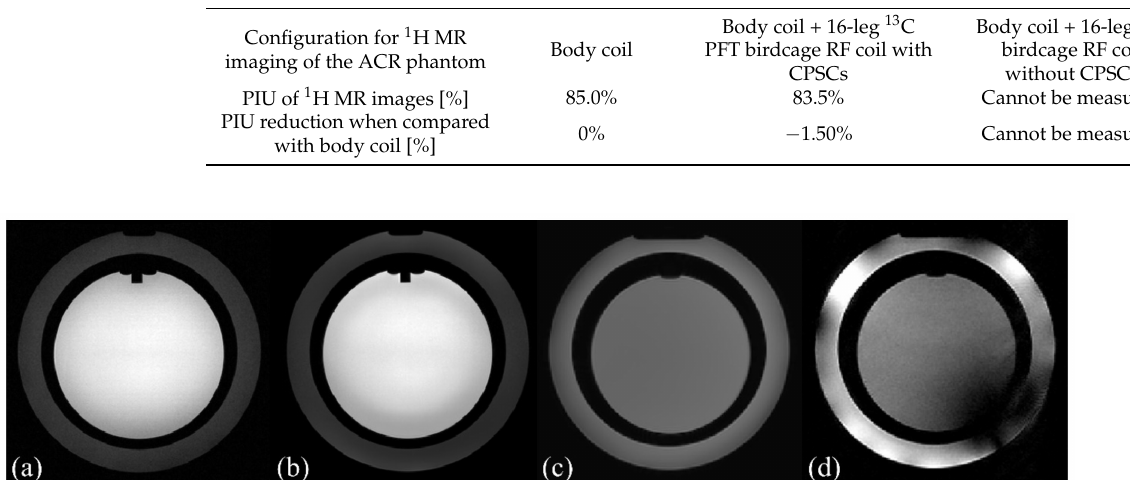
Figure 5. ACR phantom images using body coil transmission and reception without a PFT 13 C birdcage RF coil: ( a ) and with a PFT 13 C birdcage RF coil: ( b ) in a 3.0 T MRI system, showing almost identical uniformity as ( a ). 1 H MR images of the corn-oil phantom using body coil transmission and reception with a 16-leg low-pass PFT 13 C birdcage RF coil with CPSCs: ( c ) and with a 16-leg low-pass 13 C birdcage RF coil without CPSCs: ( d ) in a 3.0 T MRI system. 1 H MR image of corn-oil phantom in ( d ) shows inhomogeneity compared with ( c ), which verifies that proposed CPSCs act appropriately